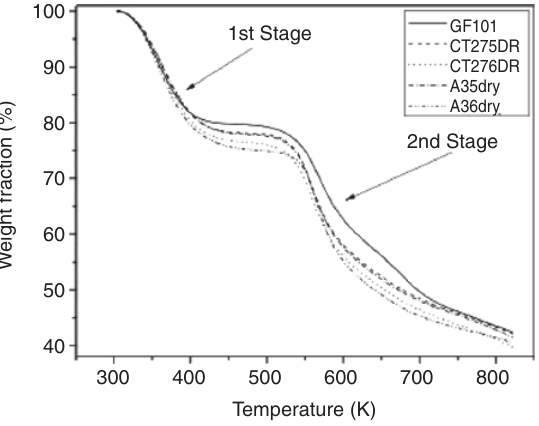
Figure 4: Thermal decomposition curves of the resins from 333 K to 823 K.